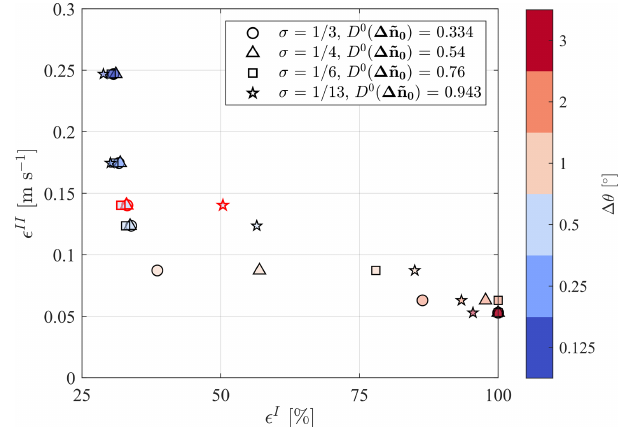
Figure 16. Pareto front for the design of the optimal lidar scan for the reconstruction of the wakes statistics for turbines F01–F04. The markers highlighted in red represent the actual lidar data after qual- ity